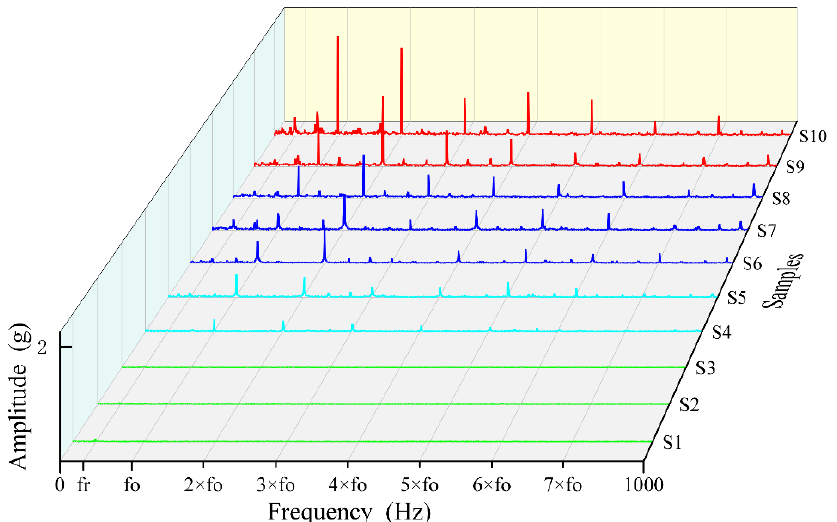
Figure 11. Spectral changes in Bearing 3_1 in different periods. In this figure, fr stands for the rotational frequency of Bearing 3_1, fo stands for the outer-ring fault frequency of Bearing 3_1, 2 × fo, 3 × fo . . . 7 × fo represents the doubling frequency of Bearing 3-1 outer-ring fault frequency; S1, S2, and S3 represent the spectrum of the Bearing 3_1 health state, S4 and S5 represent the spectrum at the initial stage of the fault, S6, S7 and S8 represent the spectrum at the middle stage of the fault, and S9 and S10 represent the spectrum at the late stage of the fault.